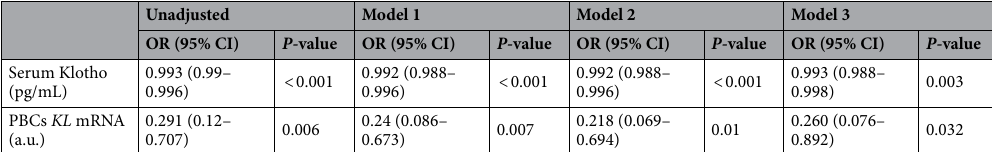
Table 4. Multivariate logistic regression analysis for the presence of subclinical atherosclerosis with serum Klotho and KL PBCs mRNA levels as independent variables. OR values are expressed per unit variation. Model 1 was adjusted by age, hypertension, current smokers, diabetes mellitus, hyperlipidemia. Model 2 was Model 1 adjusted by macroalbuminuria and eGFR. Model 3 was Model 2 adjusted by serum levels of IL6 and TNFα/ IL10 and PBCs mRNA levels of IL6 and TNF/IL10. eGFR estimated glomerular filtrate rate, IL interleukin, TNFα tumor necrosis